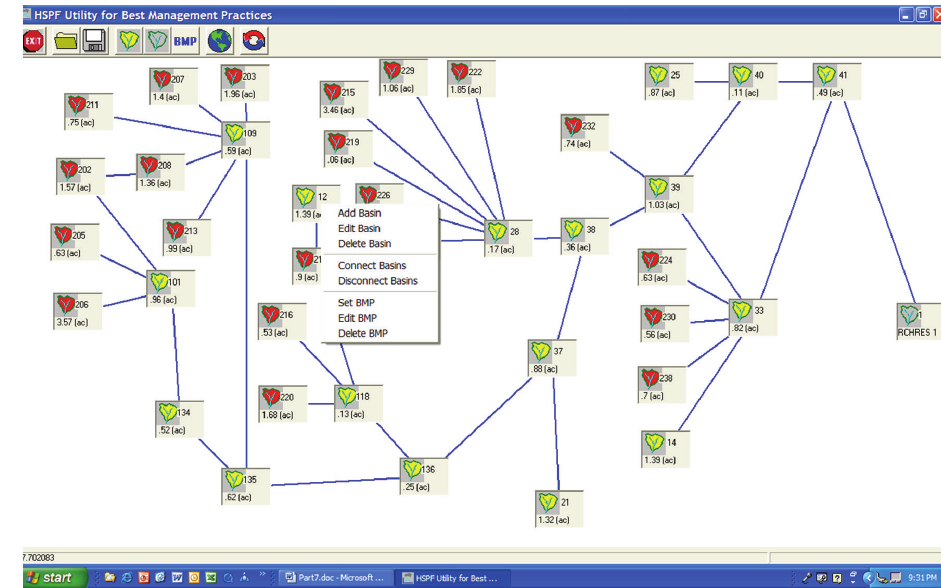
Figure 7: Simple HSPF Interface.